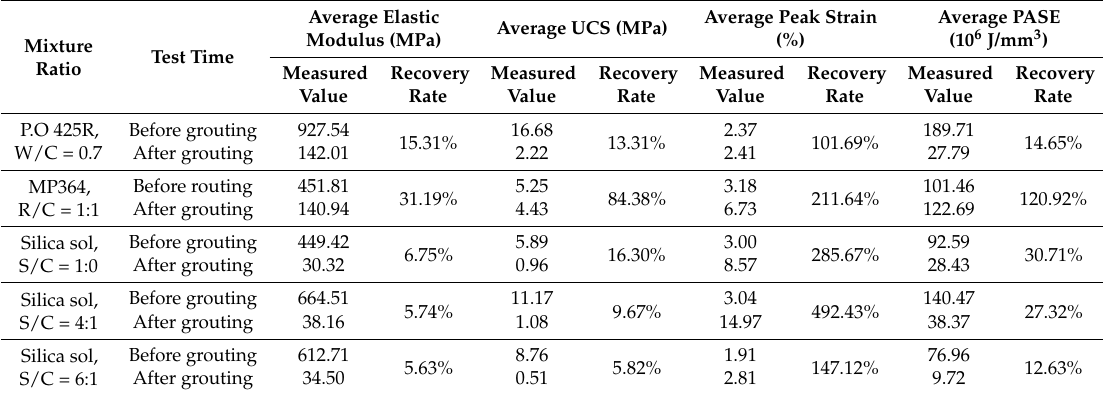
Table 4. Average test results from uniaxial compression tests of both untreated samples and samples impregnated with different kinds of grout after they had been tested to failure.